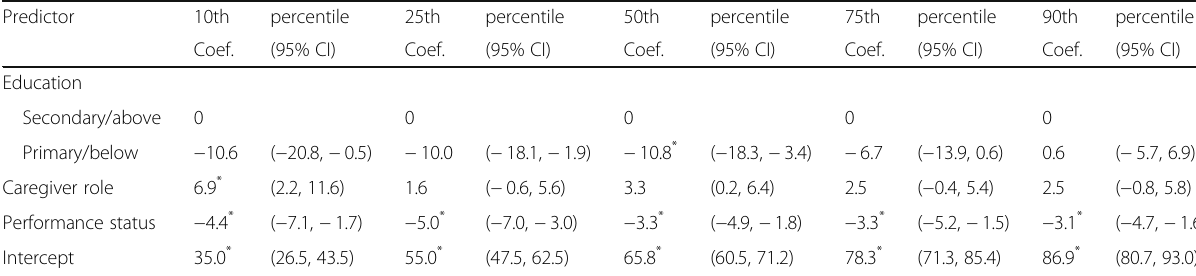
Table 5 Percentiles of QOL Mental Well-being score, final model Predictor 10th